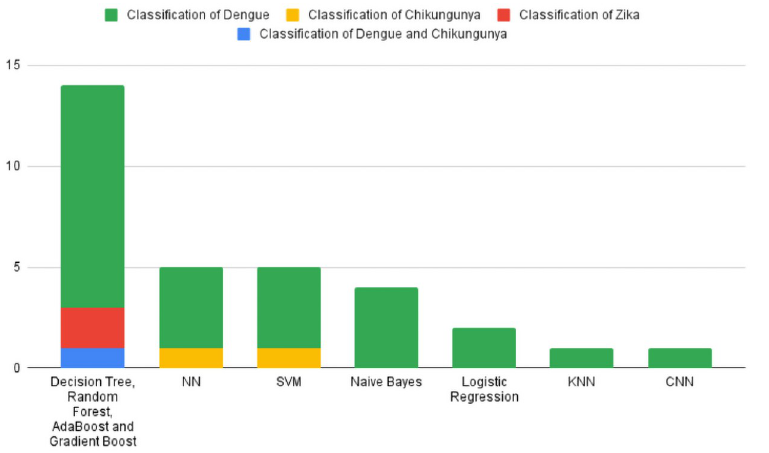
Fig 2. Models used in the works divided by the main